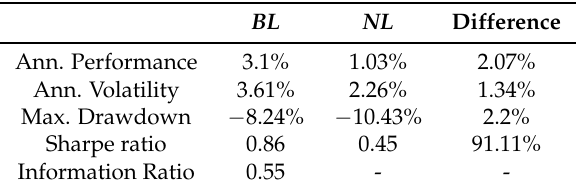
Table 13. Statistics for the BL and NL strategies. The Sharpe Ratio is calculated as the ratio between annualized performance and annualized volatility. For this case, the difference is given in relative terms. Data from January 2002 to June